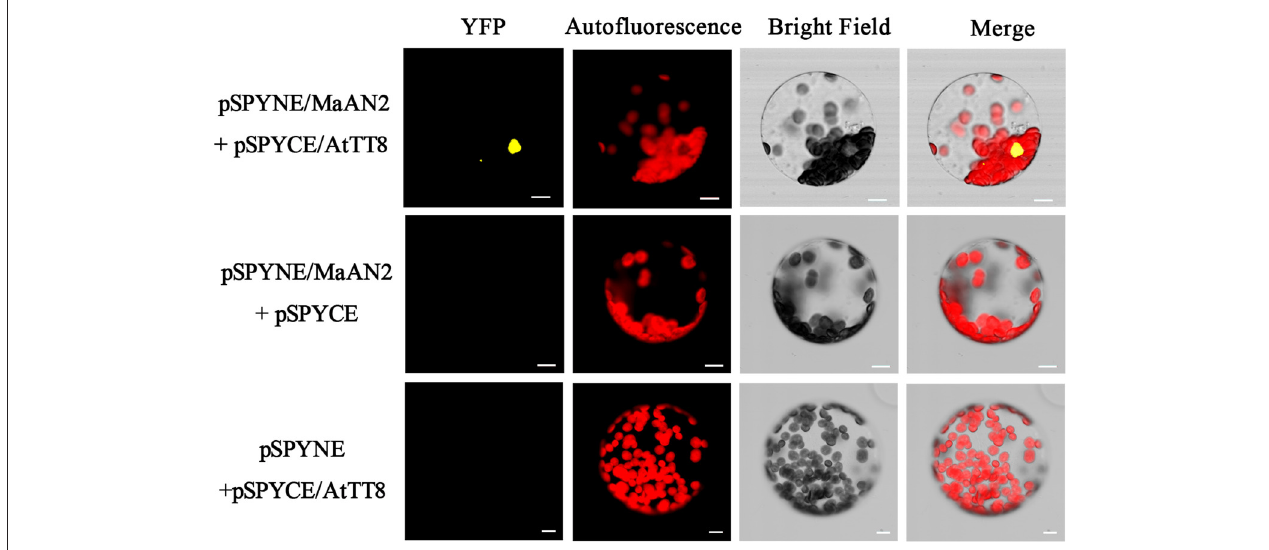
FIGURE 5 | Bimolecular fluorescence complementation of MaAN2 and AtTT8 interaction in A. thaliana mesophyll protoplasts. YFP: fluorescence of YFP; Autofluorescence: chloroplast autofluorescence; Merge is merged with chloroplast autofluorescence, YFP fluorescence, and bright field images. Bars, 10 µ